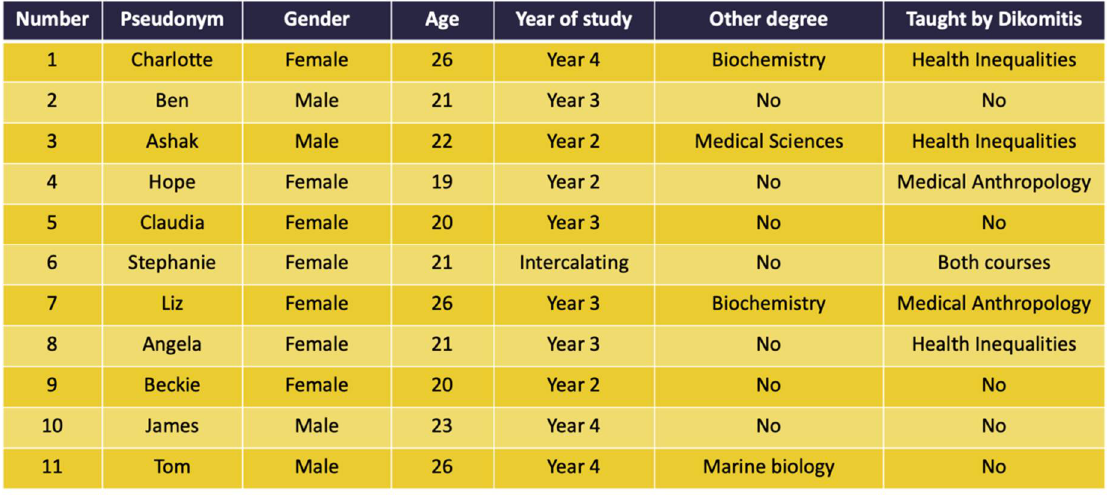
Figure 3. Characteristics of the 11 interview participants.